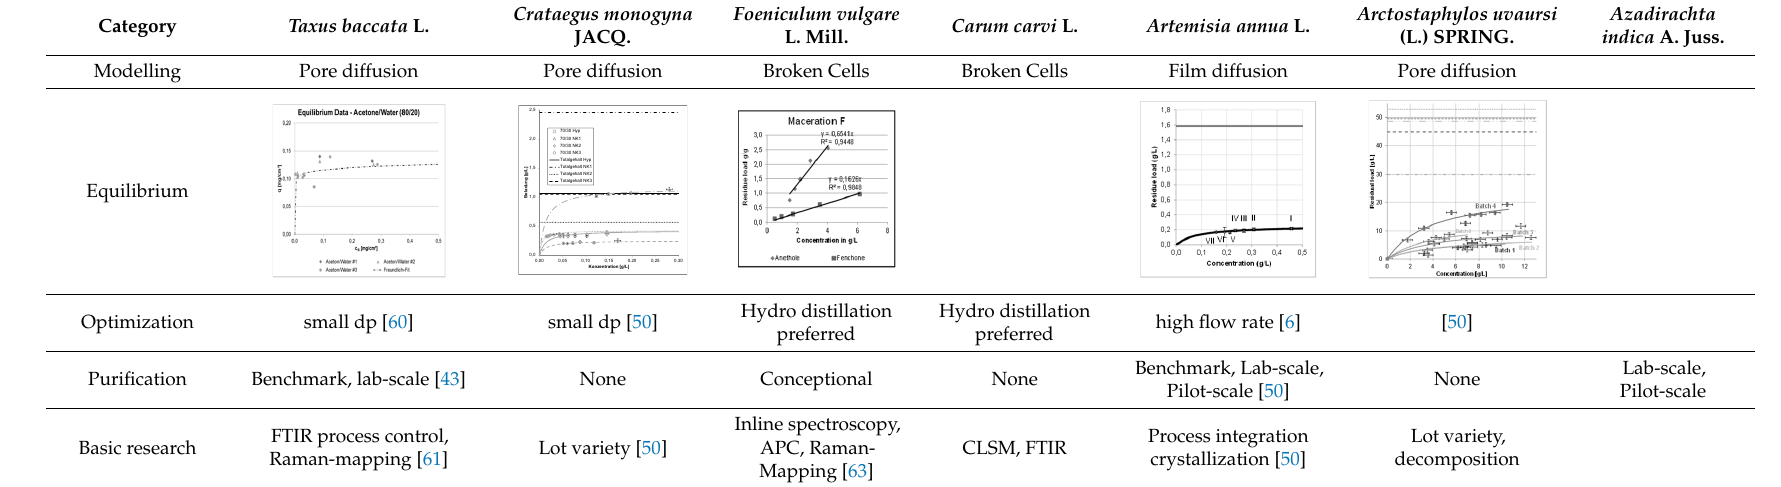
Table 4. Database of the physical properties of various herbal raw material for process design (continued).